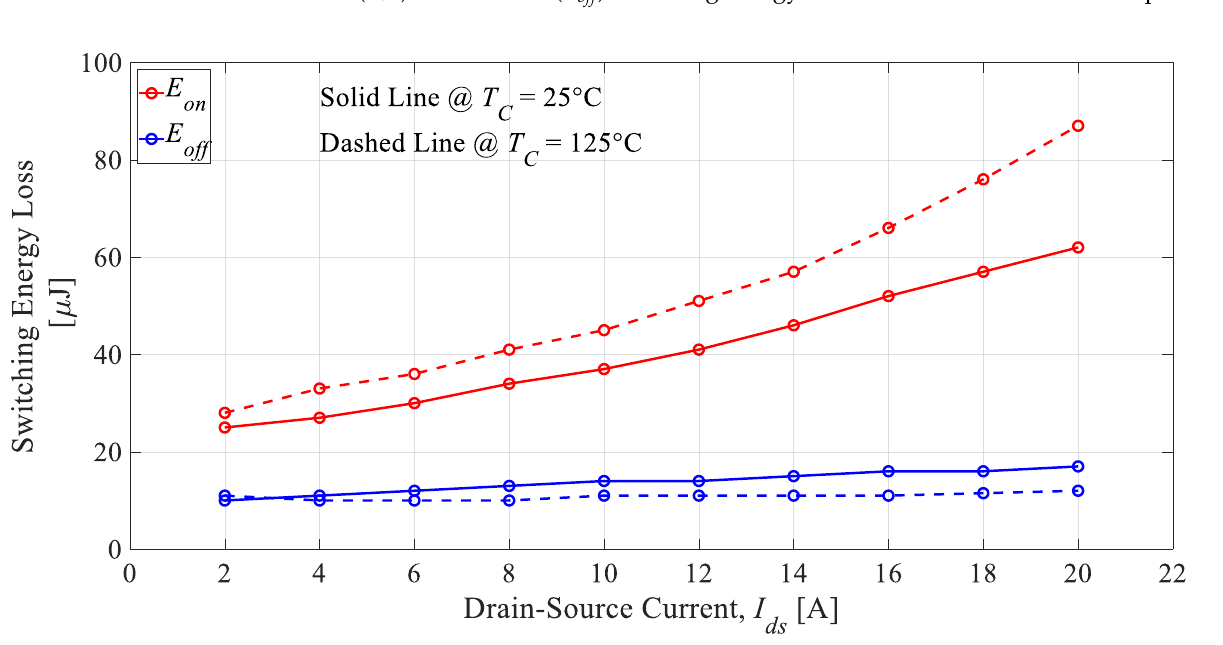
Figure 4. Switching energy loss as a function of the drain-source current at 400 V and two different case